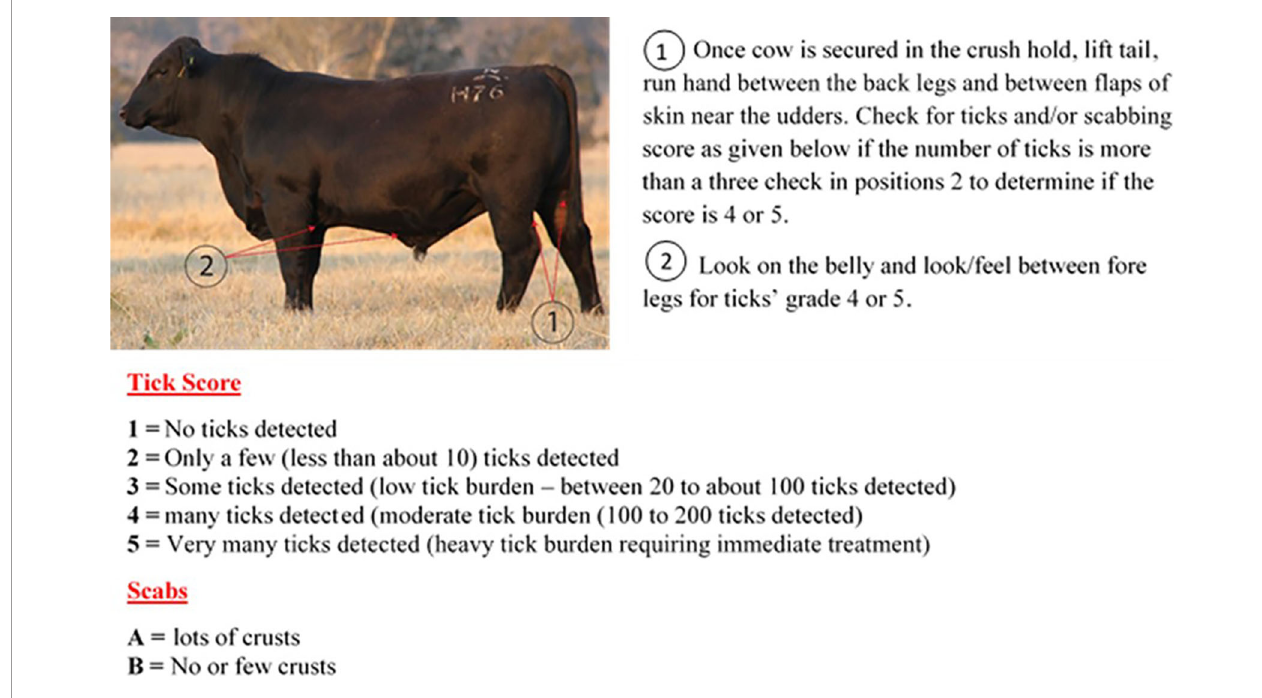
FIGURE 1 | Cow tick scoring methodology based on the number of ticks and scabs detected in the body of the